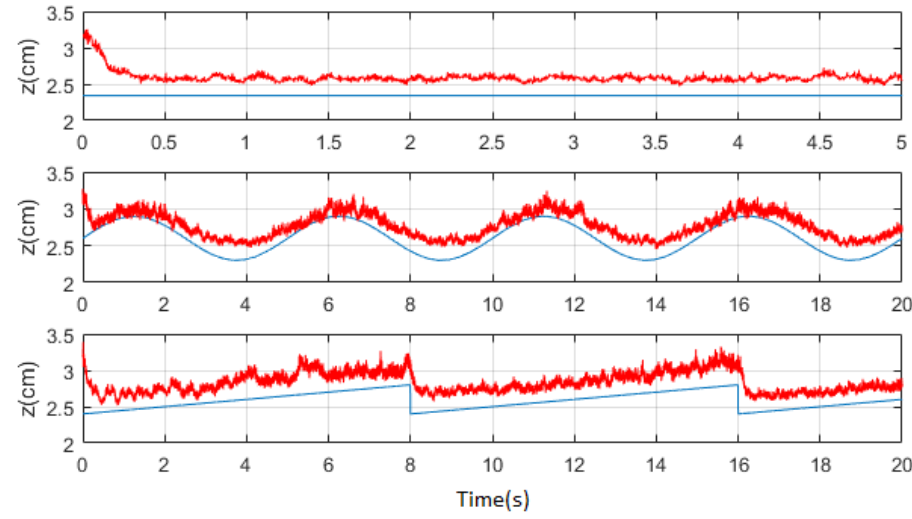
Figure 17. Responses of the real system when controlled by the 1th5s5d network.